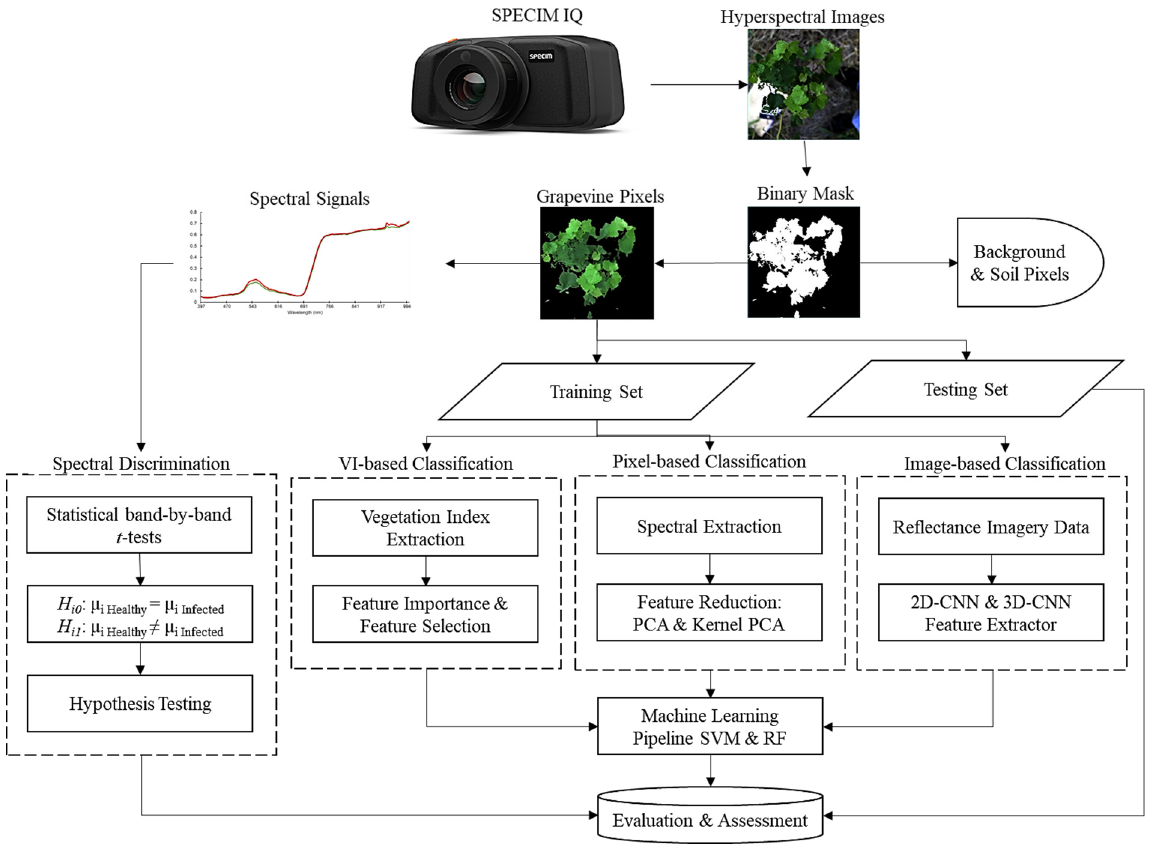
Figure 2. The overall workflow diagram of data processing and modeling pipeline.